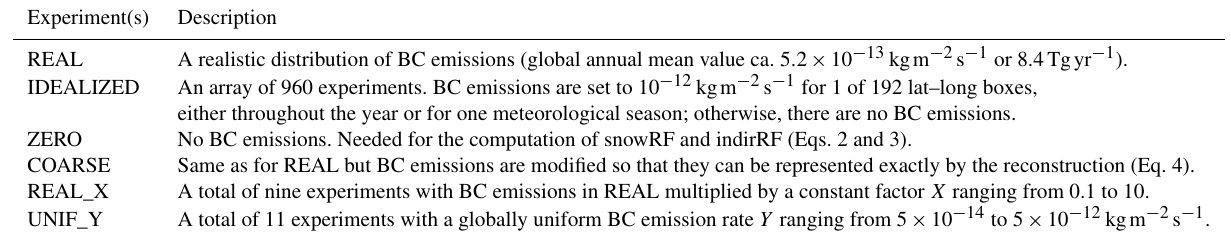
Table 1. List of NorESM1-Happi experiments. Experiment(s)